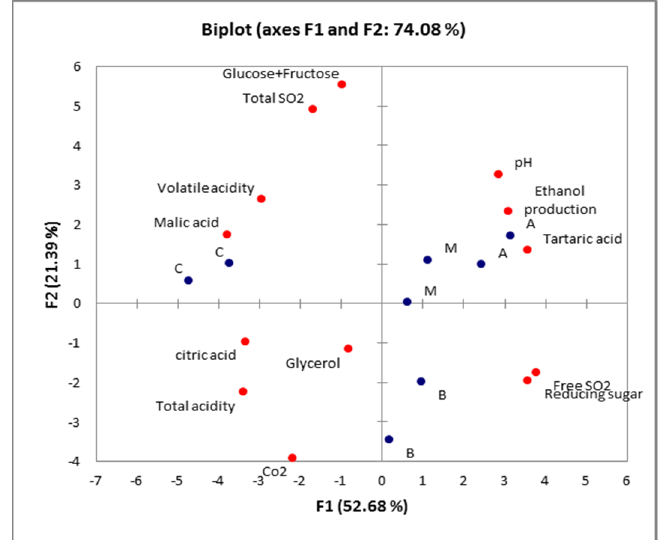
Figure 2. Sugar consumption (g / L) during pilot fermentation in the winery. A: wine inoculated by the strain M.6.16; B: wine inoculated by the strain M.10.16; C: wine inoculated by the strain M.4.17; M: wine fermented spontaneously (control).